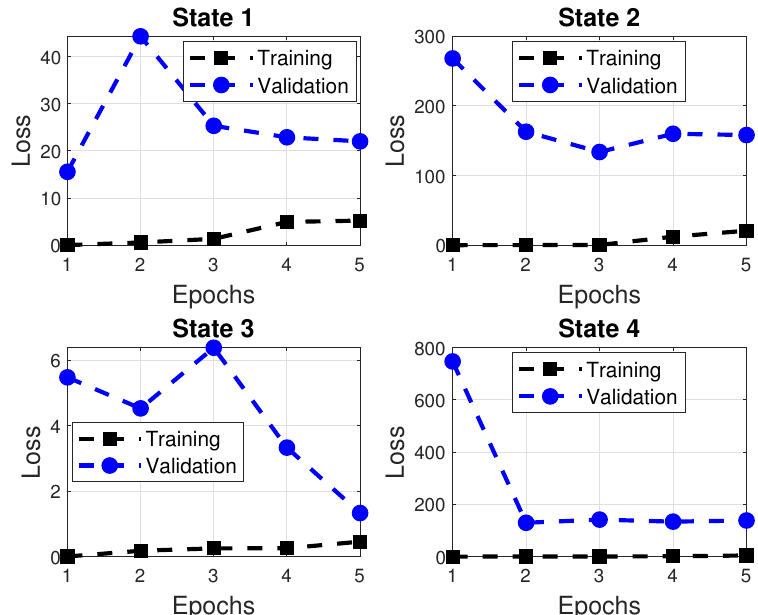
Figure 6. Training and validation MSE losses for Linear Regression.